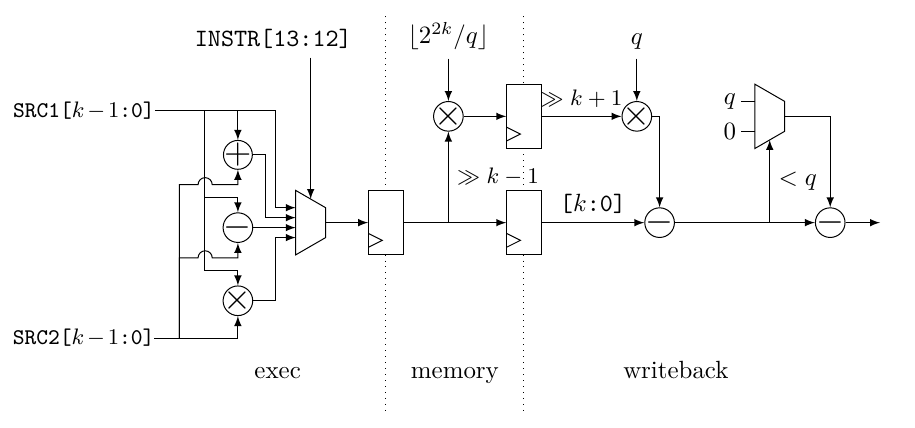
Figure 4: Circuit diagram for the custom instructions in Z q with q < 2 k . Algorithm 3: Barrett reduction algorithm.